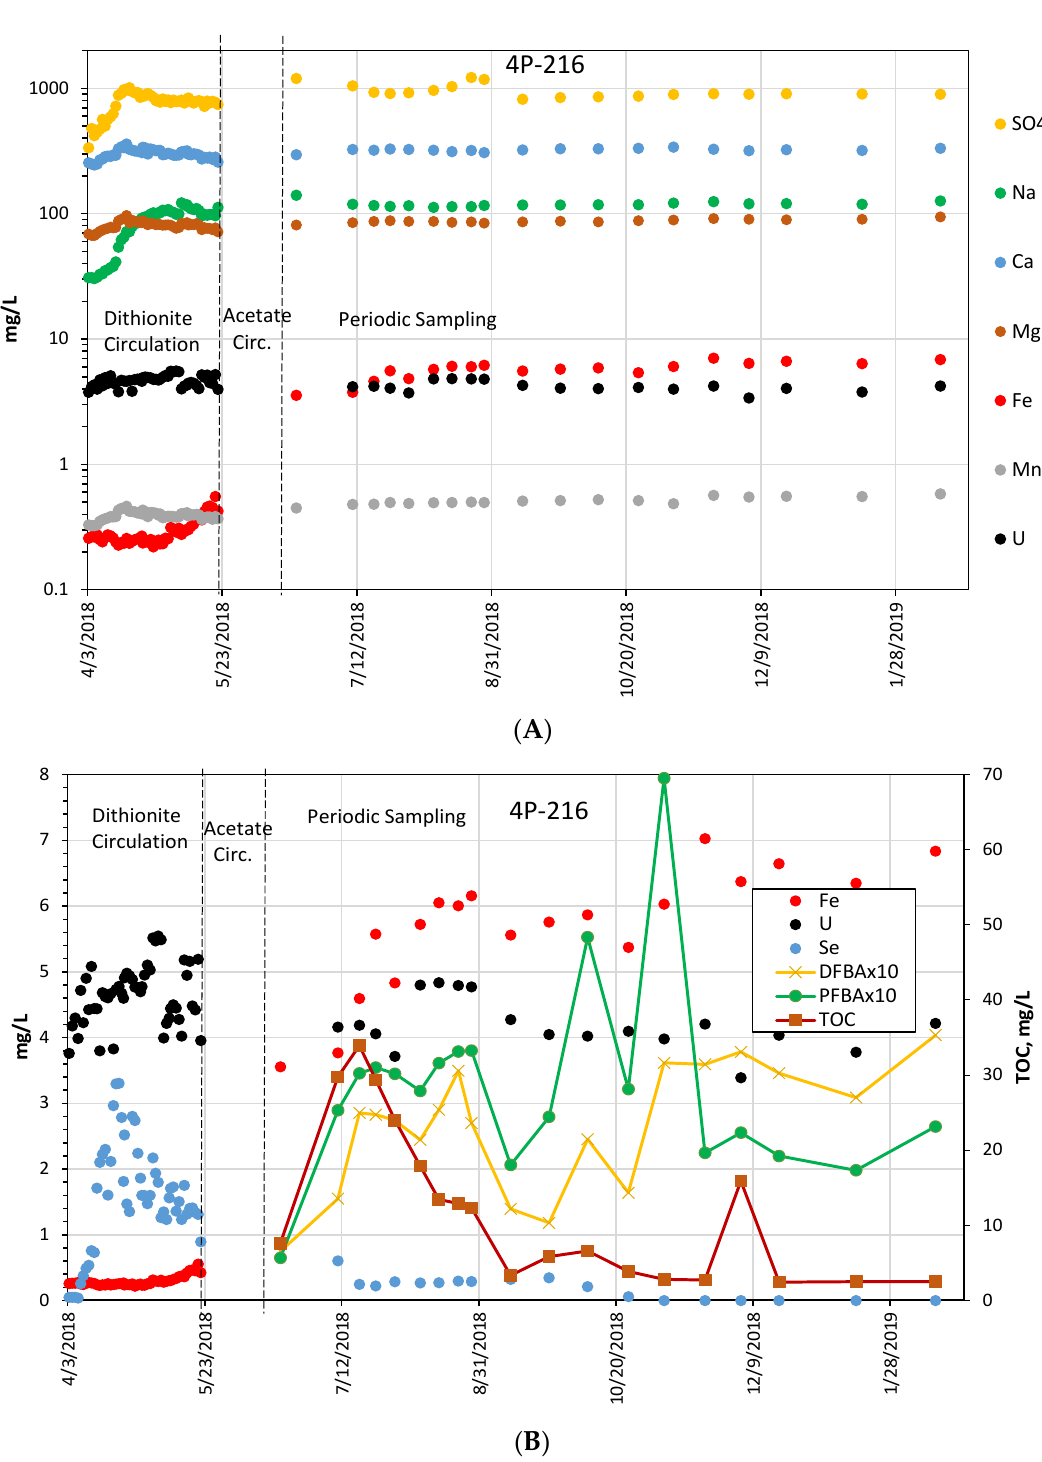
Figure A23. ( A ) Concentration histories of several key constituents in production well 4P-211 during the amendment test. ( B ) Concentration histories of redox-sensitive constituents (Fe(II), U, Se), TOC (as acetate surrogate), and tracers. Note that difluorobenzoate (DFBA) and pentafluorobenzoate (PFBA) concentrations are multiplied by 10.